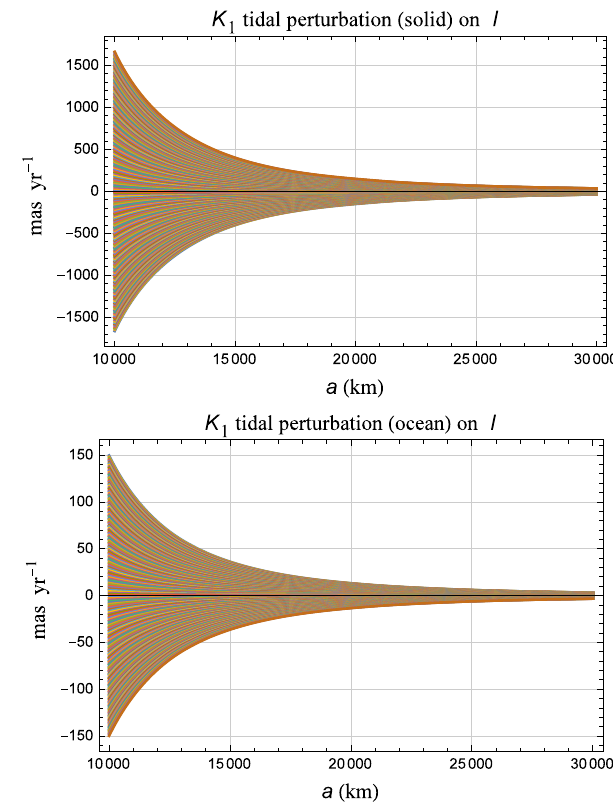
( 0 ) , C + levels of mismodeling in k are about (cid:2) 10 − 3 [30] or 2 , 1 , K 1 2 , 1 , K 1 3 × 10 − 4 [35], and 4 × 10 − 2 [42] or, perhaps, even better ( (cid:2) 10 − 3 ) if the global ocean models TPXO.6.2 [21], GOT99 [56] and FES2004 [48] are compared,